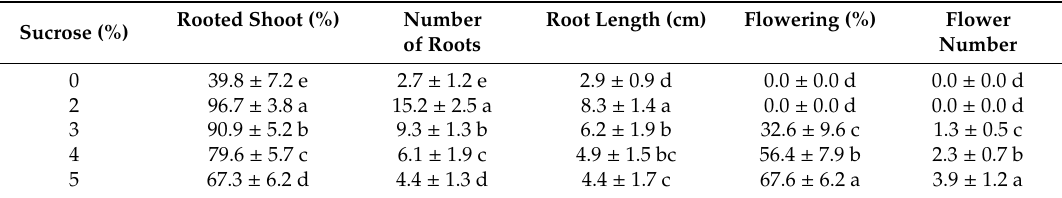
Table 7. E ff ect of sucrose on in vitro rooting and flowering of Catharanthus roseus .